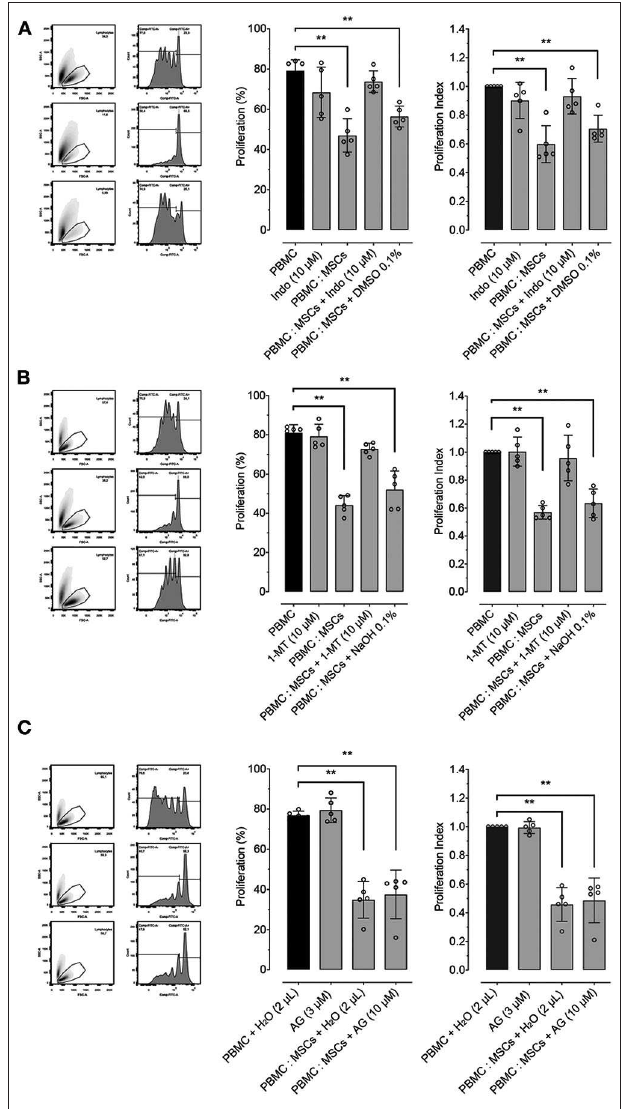
FIGURE 3 | MSCs inhibitory effect on lymphocyte proliferation is dependent on PTGS2 and IDO function. Lymphocyte proliferation induced by incubation of peripheral blood mononuclear cells (PBMC) with 5 µ g/mL of concanavalin A (ConA), cultured alone or co-cultured with MSCs at 16:1 ratio. (A) Effect of prostaglandin-endoperoxide synthase 2 (PTGS2) inhibition with 10 µ M of indomethacin on the inhibitory effect of MSCs on lymphocyte proliferation. (B) Effect of indoleamine 2, 3 dioxigenase (IDO) inhibition with 2 µ M of 1-Methyltryptophan (1-MT) on the inhibitory effect of MSCs on lymphocyte proliferation. (C) Effect of inducible nitric oxide synthase (iNOS) inhibition with 1.5 µ M of aminoguanidine (AG) on the inhibitory effect of MSCs on lymphocyte proliferation. Two µ L of water was added to the control condition as vehicle (** p < 0.01; n =